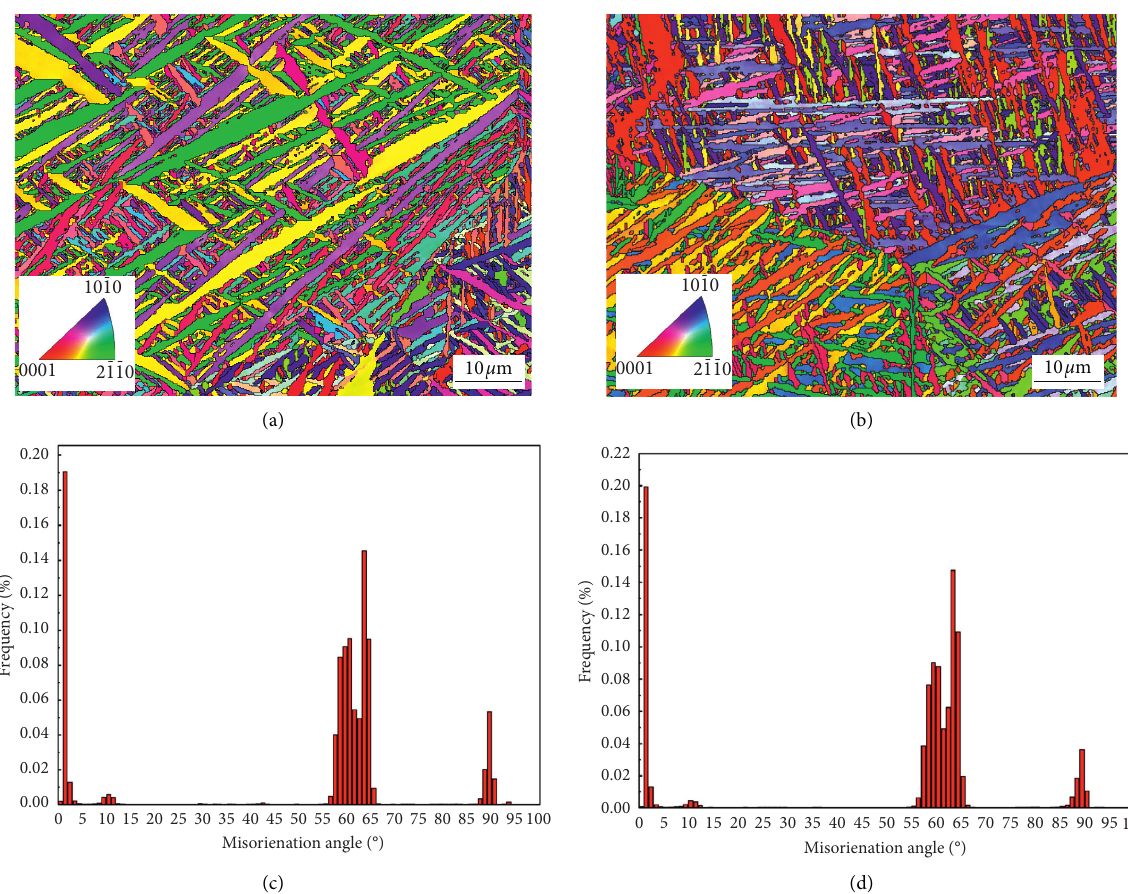
Figure 8: EBSD maps (a), (b) and the angle distribution curve of TC4 titanium alloy welded under different shielding gas states (c),